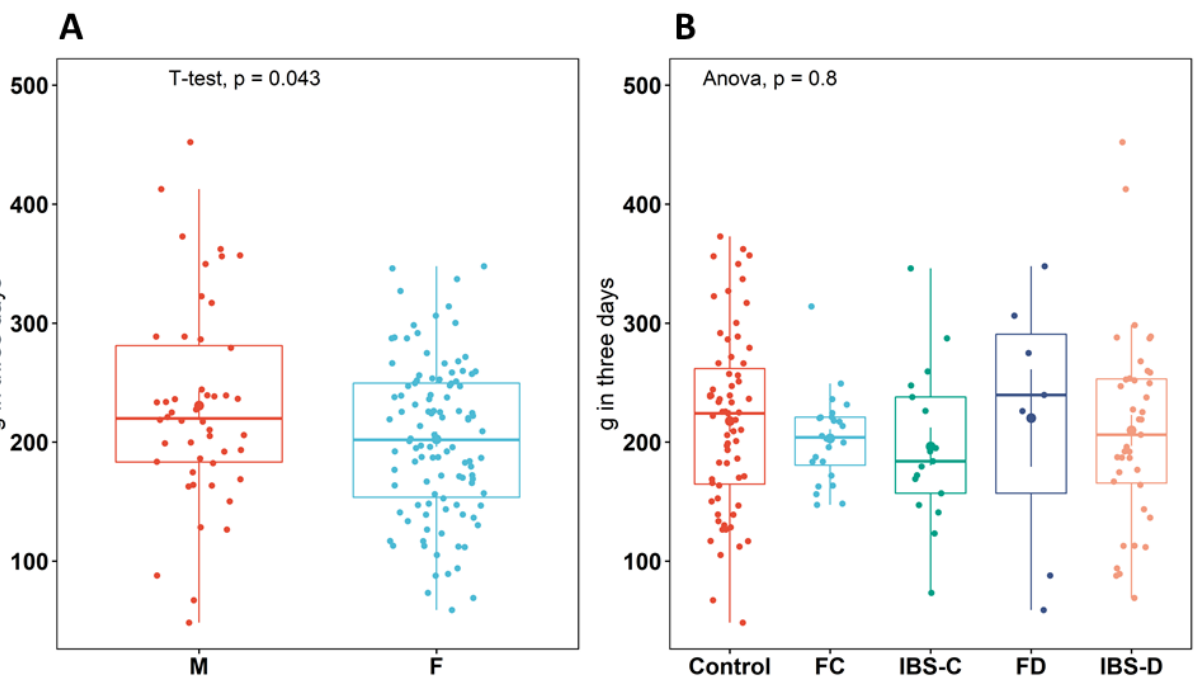
Figure 1. Total sum (g) of dietary protein intake over three days recording using diet diaries for each participant between ( A ): male and female individuals ( B ): between healthy control (control), IBS subtypes (IBS-C, IBS-D), and functional groups (FC, FD), data from males and females combined. Boxplots show the median (center line), 25th and 75th percentile (top and bottom of boxes, respectively), and whiskers representing 1.5 times the interquartile range. Abbreviations: healthy control (control), functional constipation (FC), IBS-constipation (IBS-C), functional diarrhea (FD), and IBS-diarrhea (IBS-D). Colors identifies subtype or healthy control groups.